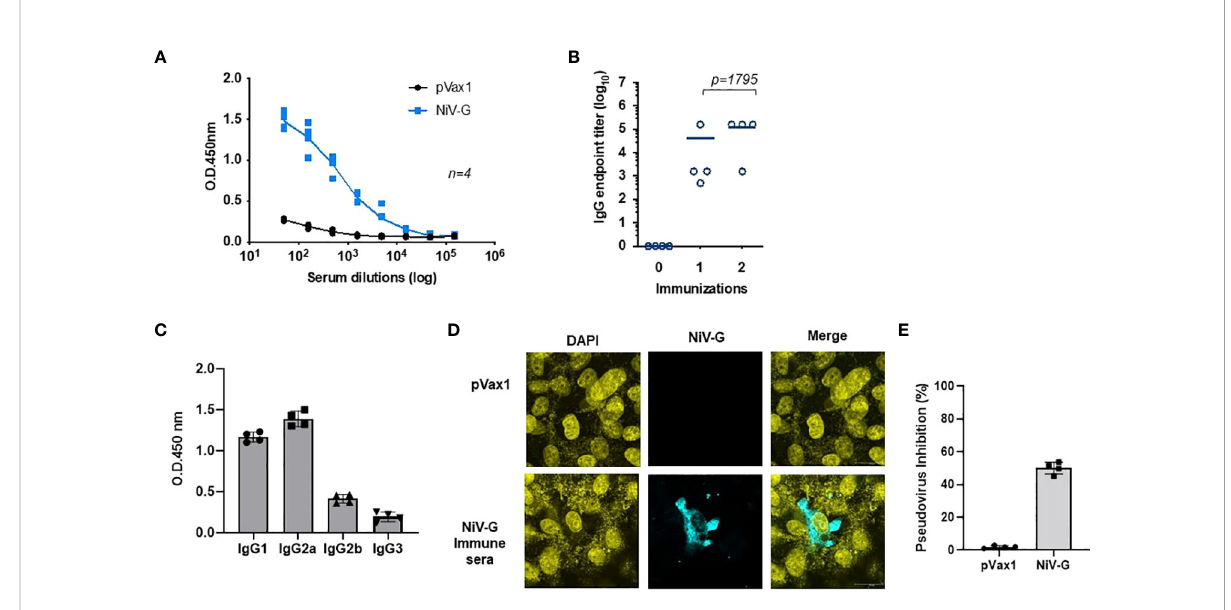
FIGURE 3 Evaluation of NiV-G antigen-speci fi c antibody responses following immunization of mice with NiV-G vaccine. (A) NiV-G speci fi c-antibody responses were measured in sera collected two weeks after the second immunization (day 28). Recombinant NiV-G protein was used in ELISA to assess the antigen-speci fi c antibody responses. (B) Endpoint titers for the single and two immunization samples were measured in sera collected on day 14 (indicated as immunization 1) and 28 (indicated as immunization 2) post-immunization ( n=4 mean ± SEM). (C) IgG1, IgG2a, IgG2b, and IgG3 subclass of mouse sera were determined by ELISA in samples collected two weeks post second immunization (day 28). (D) Immuno fl uorescence assay demonstrated that IgG generated from NiV-G vaccine-administered mice was capable of binding to NiV-G vaccine- transfected cells. (E) Day 28 immune sera from each mouse were diluted at 1:20 and used to measure inhibition ability for NiV-F/G pseudovirus. Sera samples were measured in duplicates and the data shows one of two representative